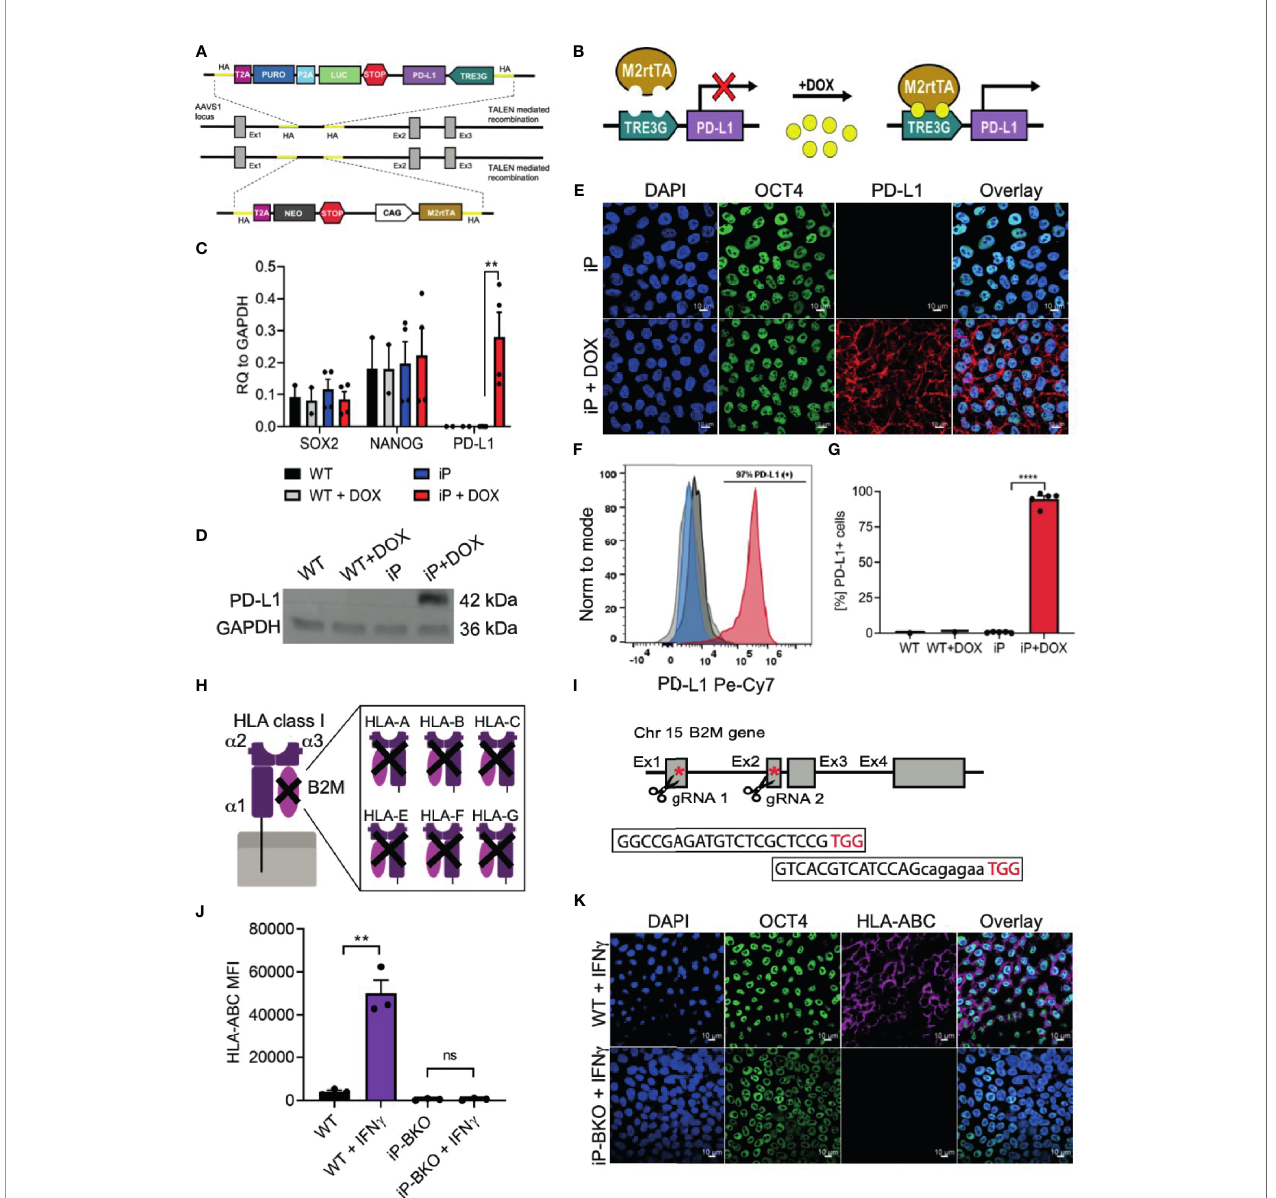
FIGURE 2 | Integration of immune protective gene editing in hPSC using genome engineering. (A, B) Schematic of TALEN-mediated recombination strategy for the integration (A) and mechanism of action (B) of a Tet-On DOX inducible PD-L1 expression system between exon1 and 2 of the AAVS1 locus in the hPSC Mel1 INS-GFP line. (C) qPCR analysis of control hPSC (WT) and inducible PD-L1 hPSC (iP) cells with and without DOX treatment (2ug/ml for 48hr). Pluripotency markers SOX2 and NANOG were also analyzed. Values are normalized to GAPDH and shown as mean +/- SEM of n = 2 for WT and n = 4 for iP samples. 2way-Anova with Tukey ’ s multiple comparison test was performed with **p ≤ 0.01. (D) Immunoblotting for PD-L1 and loading control GAPDH proteins in WT and iP cells with and without DOX treatment. Representative immunoblot of 3 independent repeats. Complete blot is presented in Supplementary Figure 2B . (E) Representative immuno fl uorescence images of iP cells with and without DOX treatment. Sample were stain for DAPI (blue), OCT4 (green), and PD-L1 (red). Representative image of 4 independent experiments. Scale bar represents 10um. (F, G) Representative fl ow cytometry histogram (F) and quanti fi cation (G) for the detection of surface PD-L1 protein on WT (black), WT + DOX (light gray), iP (blue), and iP + DOX (red) cells. Results from n = 5 for iP and n = 1 for WT are shown as mean +/- SEM. Unpaired student ’ s t test was performed with ****p ≤ 0.0001. (H, I) Structural schematic of HLA class I complex with membrane bound a 1 region, peptide binding grove composed of a 2 and a 3 regions and the invariable B2M region (H) . Inhibition of surface expression of all HLA class I isoforms is achieved by deletion of functional B2M using CRIPSR-Cas9 technology. Sequence for the two gRNAs speci fi c for exons 1 and 2 with corresponding PAM sequences (in red) and location in relation to the B2M gene is shown with red asterisks (I) . (J) Flow cytometry quanti fi cation of surface HLA-ABC expression on WT and iP cells with B2M KO (iP-BKO) after IFN- g treatment (100ng/ml for 48hr). MFI values are presented as mean +/- SEM for 3 independent experiments. Unpaired student ’ s t test was performed with **p ≤ 0.01; ns, not signi fi cant. (K) Representative immuno fl uorescence images of iP-BKO cells after IFN- g stimulation. Samples were stain for DAPI (blue), OCT4 (green), and HLA-ABC (purple). Scale bar represents